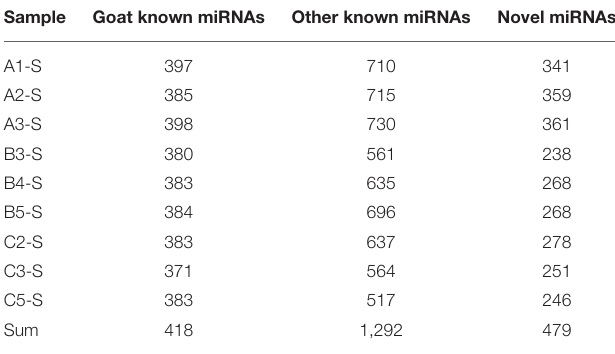
TABLE 1 | Reults of miRNA